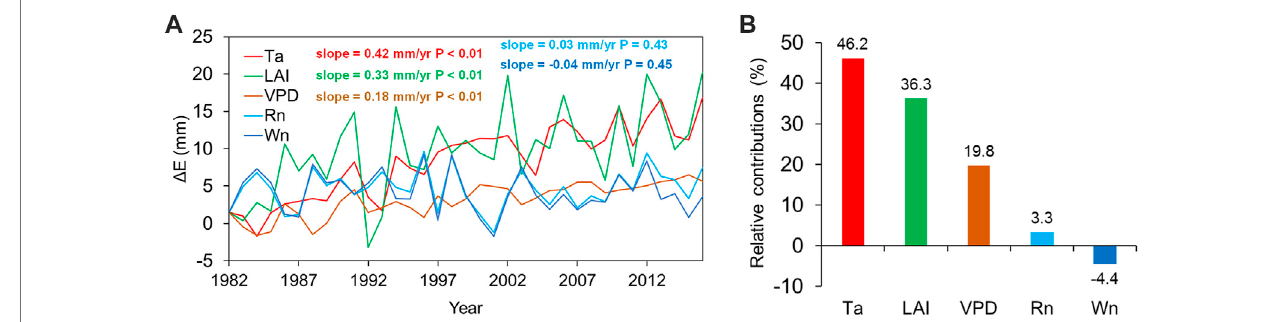
FIGURE 4 | Climate and vegetation contributions to changes in dry-season E during the study period. (A) Net effects of climate and vegetation on dry-season E changes during the study period of 1982 – 2016 (B) their corresponding relative contributions. Ta, LAI, VPD, Rn, and Wn are air temperature, leaf area index, vapor pressure index, solar radiation, and wind speed, respectively. The dry-season E estimated with all varied variables showed a signi fi cant increase with a rate of 0.91 mm/yr.